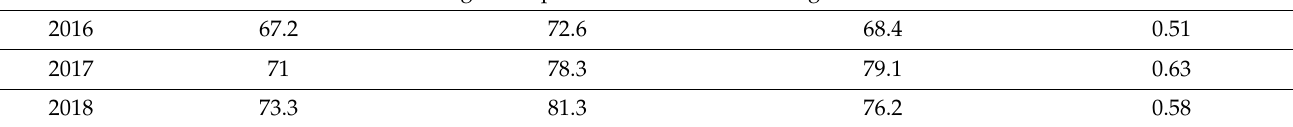
Table 4. Summary of all the classification performances conducted in the Crau area.